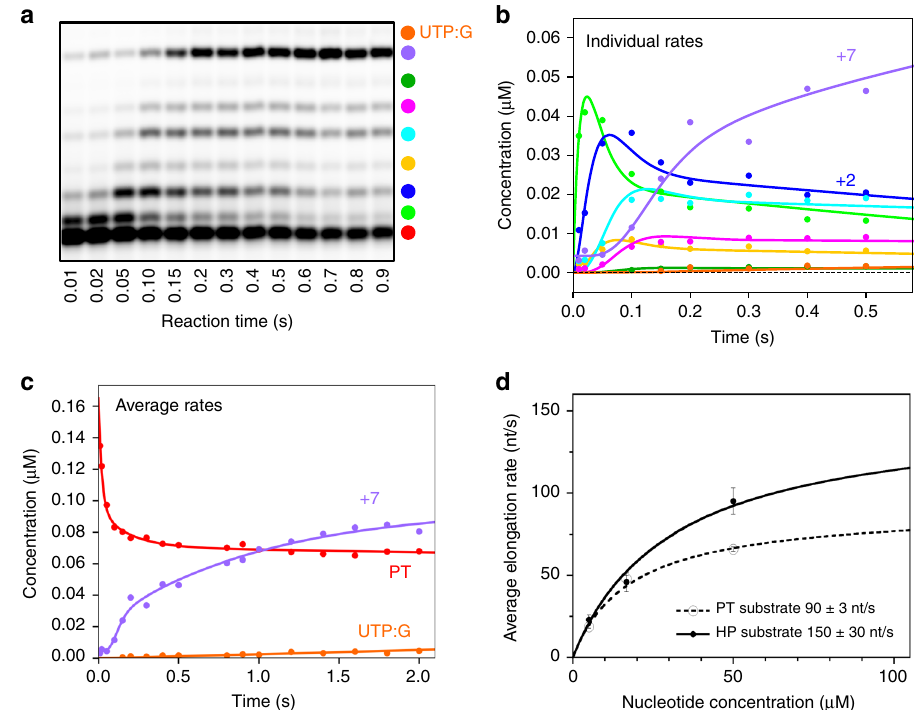
Fig. 5 Pre steady-state elongation by nsp12-7L8-8 complex. a EDTA quench- fl ow data showing rapid elongation to + 7 products on the PT10/ 20 substrate in the absence of CTP. b , c Fitting of the quench- fl ow data to models with discrete rates for each elongation step ( b , colour key in a ) or with a single average incorporation rate for each step c . d Nucleotide concentration dependence yielding maximal elongation rates of 150 ± 30 s − 1 on the HP substrate and 91 ± 4 s − 1 on the PT substrate based on error weighted fi ts to the observed average elongation rates. Experiments were run at three NTP concentrations with 20 timepoints per experiment, including repeats of 100 ms timepoints ( n = 3). Supplementary Table 1 lists rates ± standard error (S.E) for both an overall average rate and for each individual incorporation step. Source data are provided as a Source Data fi phase, however, allowed characterisation of elongation rates under single-turnover conditions using millisecond timescale EDTA quench- fl ow (Fig. 5 and Supplementary Fig. 7). Experi- ments were performed at three NTP concentrations based on estimated steady-state K d values of 3 – 15 µM. CTP was omitted to allow elongation by only 7 and 8 nucleotides on the PT and HP substrates, respectively, while avoiding end-effects that can slow elongation rates. At 16.7 µM NTP we observe multiple